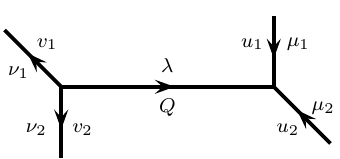
Figure 7. The example of 5-brane web where λ, µ i , ν i are Young diagram associated with edges, Q is a Kähler parameter associated with edge λ , and u i , v i are ( p, q ) -charges of four edges. to the left, to keep the orientifold plane an O5-plane. This is depicted in figure 5(b), where half D5-branes are created due to the Hanany-Witten transitions. Taking the spinor 5- branes closer to the center of the O5-plane, they undergo “generalized flop” transitions [30] but still preserve the charge conservation as giving in figure 5(c). Repeating the same procedure on the top O5-plane, one finds a 5-brane web for the 6d SO(8) gauge theory with four auxiliary spinors with a Z twist, as in figure 6. Again, to obtain the 2